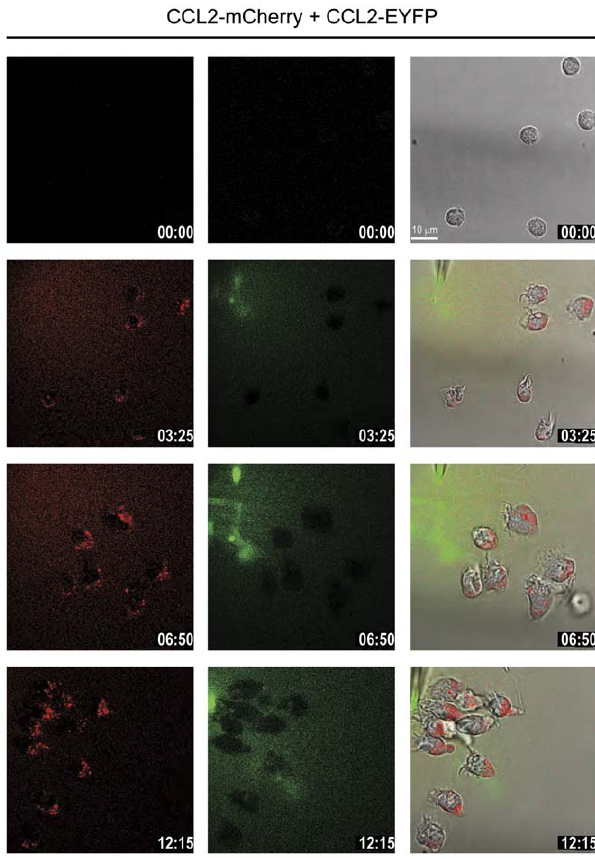
Figure 4. CCL2 uptake is D6-independent. Selected frames from time-lapse video microscopy (Movie S5) of migrating monocytes recorded at 37 u C. The micropipette was dispending 100 nM CCL2- mCherry and 10 m M of the D6 ligand CCL22 with constant back- pressure. Left panels phase images, middle panels CCL2-mCherry (ex 594 nm/em 620–680 nm), and right overlay. Time stamps are indicated in mm:ss.